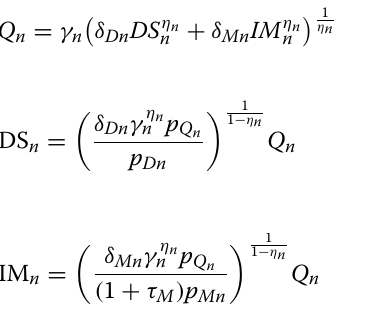
Table 2 Estimation of substitution parameter of CET function, φ n Industrial sector ( n ) S01 S02